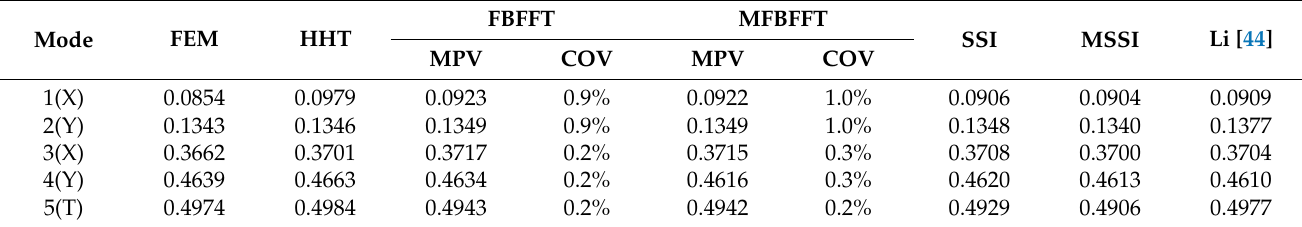
Table 6. Initial frequency and frequency band by the FBFFT method of the Canton Tower. Table 7. Identified frequencies under earthquake of the Canton Tower.